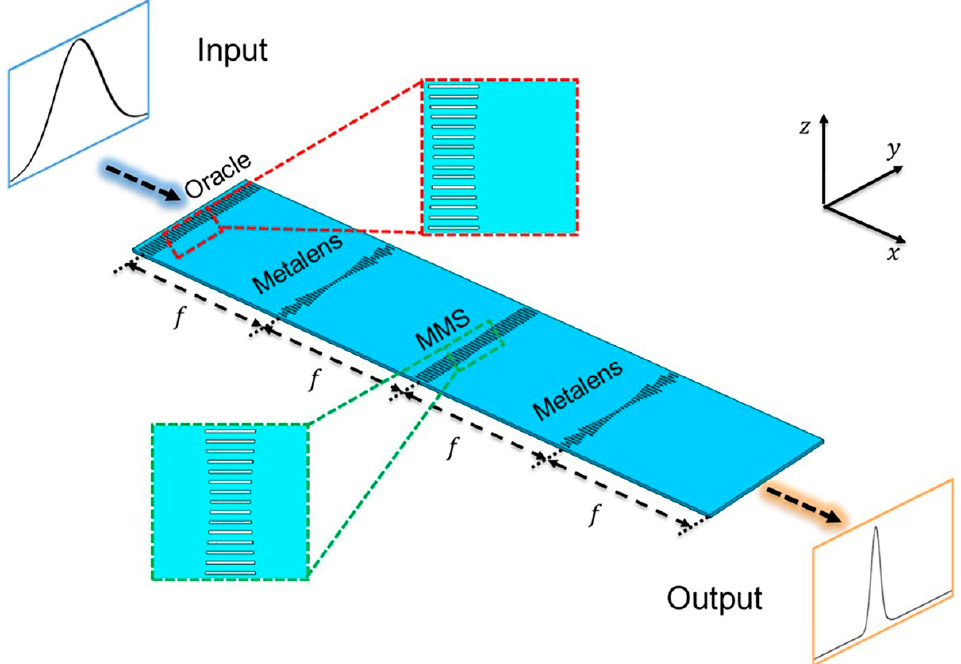
Figure 1. Schematic diagram of the proposed quantum searcher. The designed quantum searcher is comprised of four metasurfaces: an oracle metasurface, two metalenses, and a middle metasurface (MMS). Two insets: the corresponding on-chip structures. The term f = 20 μ m denote the focal length of the metalens. The TE wave of wavelength λ = 1550 nm travels in the positive x-direction (polarized in the y-direction).